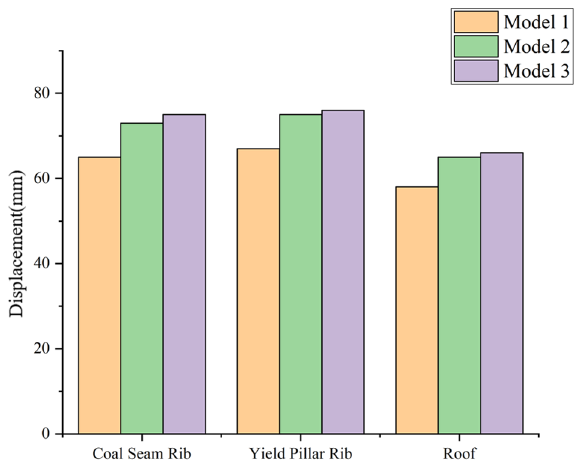
Figure 7. The effect of mesh dependency on the model.